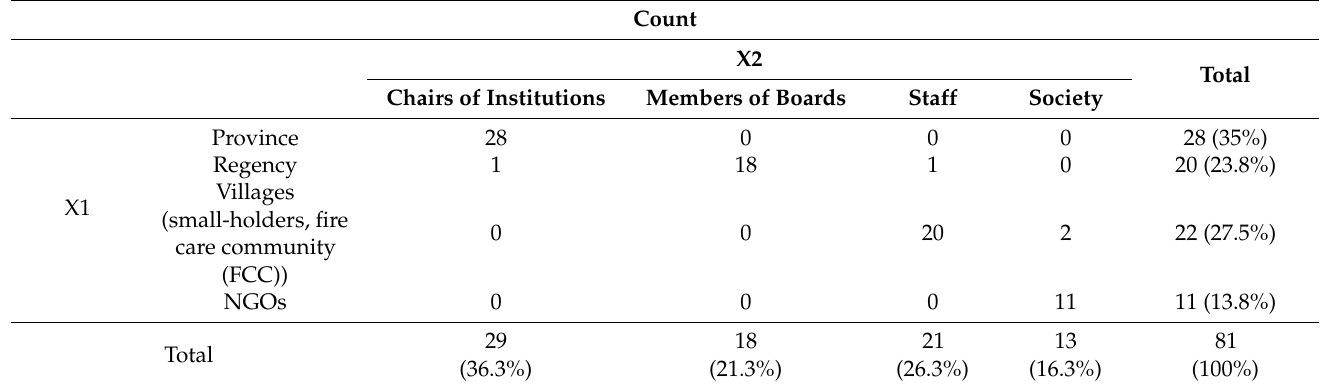
Table 1. Figures for the selected stakeholders and